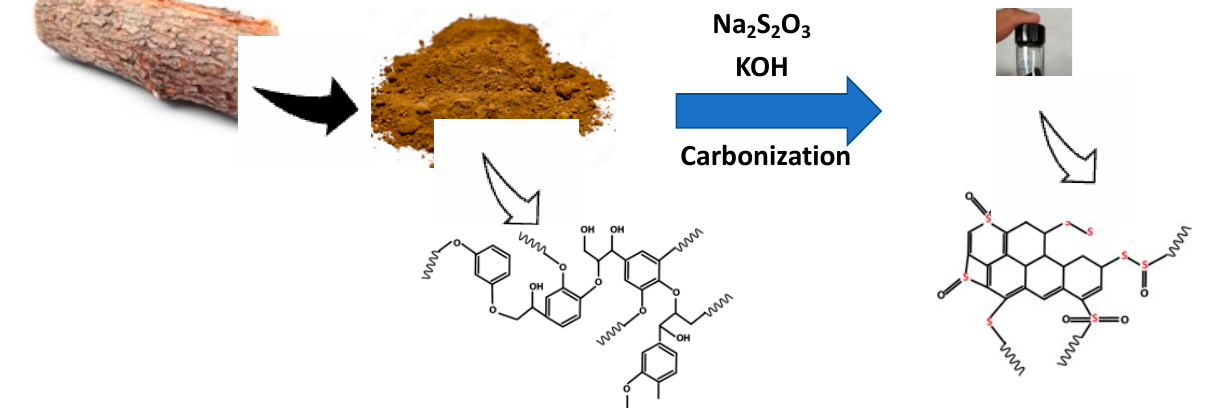
Figure 1. Schematic of one-step synthesis of sulfur-doped nanoporous carbon from lignin. Table 1. Sample identity.